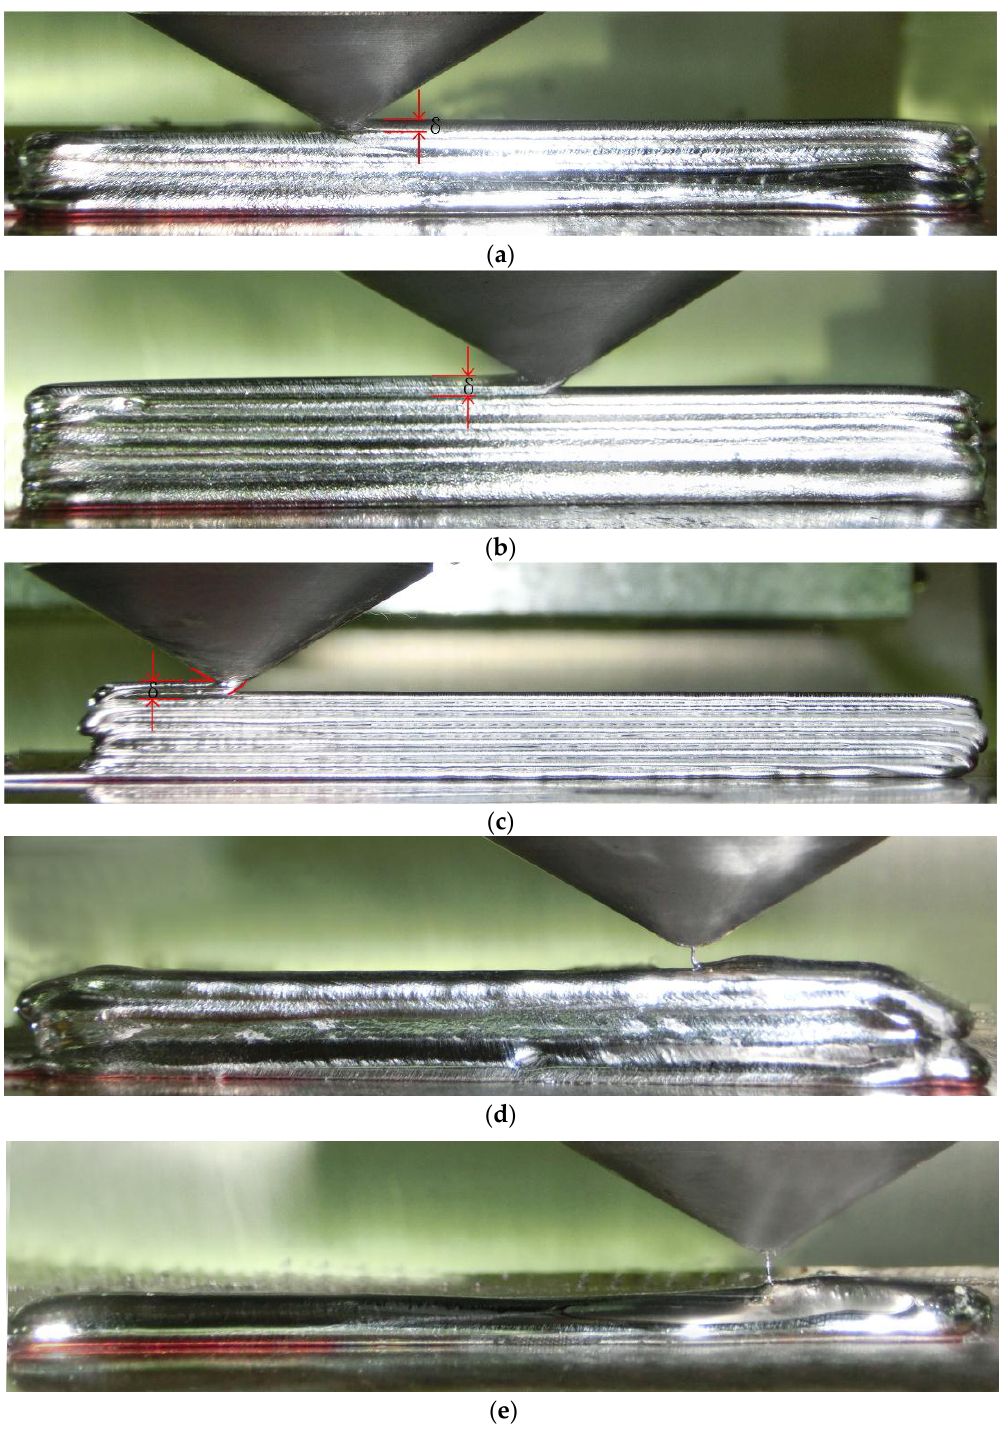
Figure 4. The deposited specimens in different layer thickness. ( a ) δ = 0.9 mm. ( b ) δ = 1.2 mm. ( c ) δ = 1.5 mm. ( d ) δ = 1.8 mm. ( e ) δ = 2.1 mm. ( c ) δ = 1.5 mm. ( d ) δ = 1.8 mm. ( e ) δ = 2.1